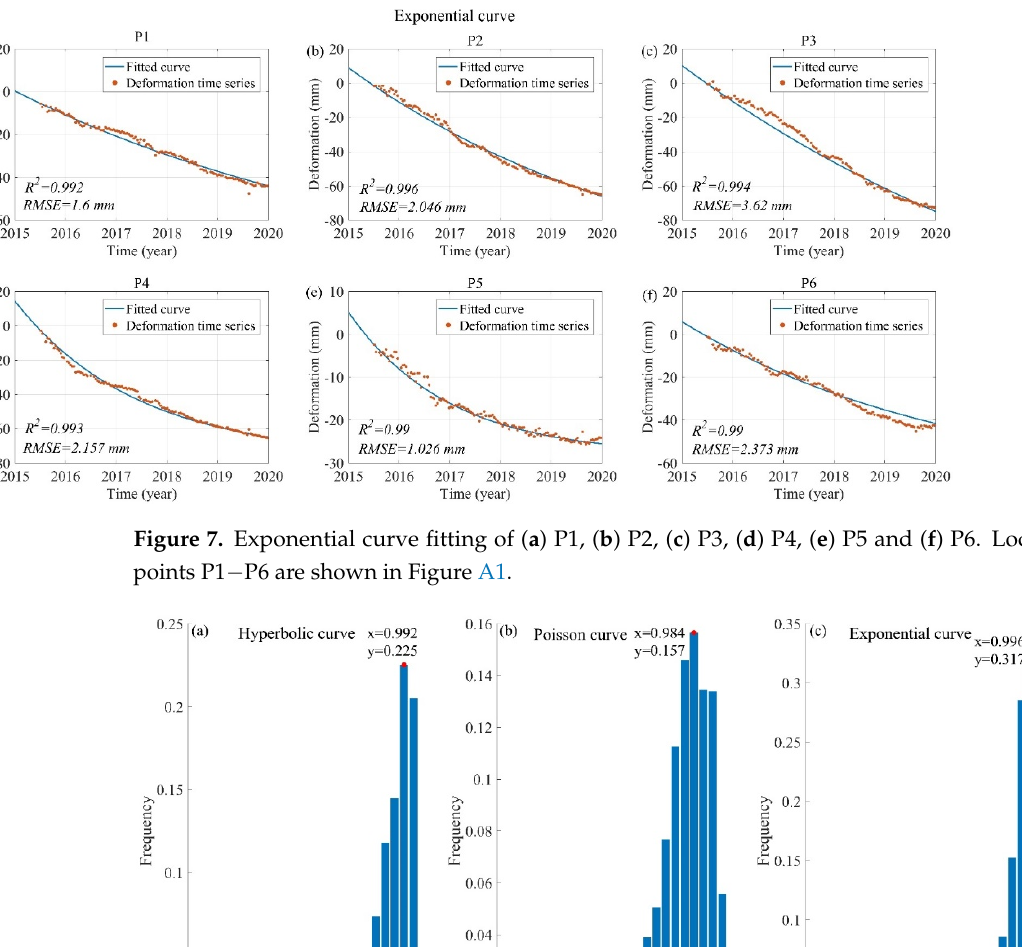
Figure 7. Exponential curve fitting of ( a ) P1, ( b ) P2, ( c ) P3, ( d ) P4, ( e ) P5 and ( f ) P6. Locations of points P1−P6 are shown in Figure A1.